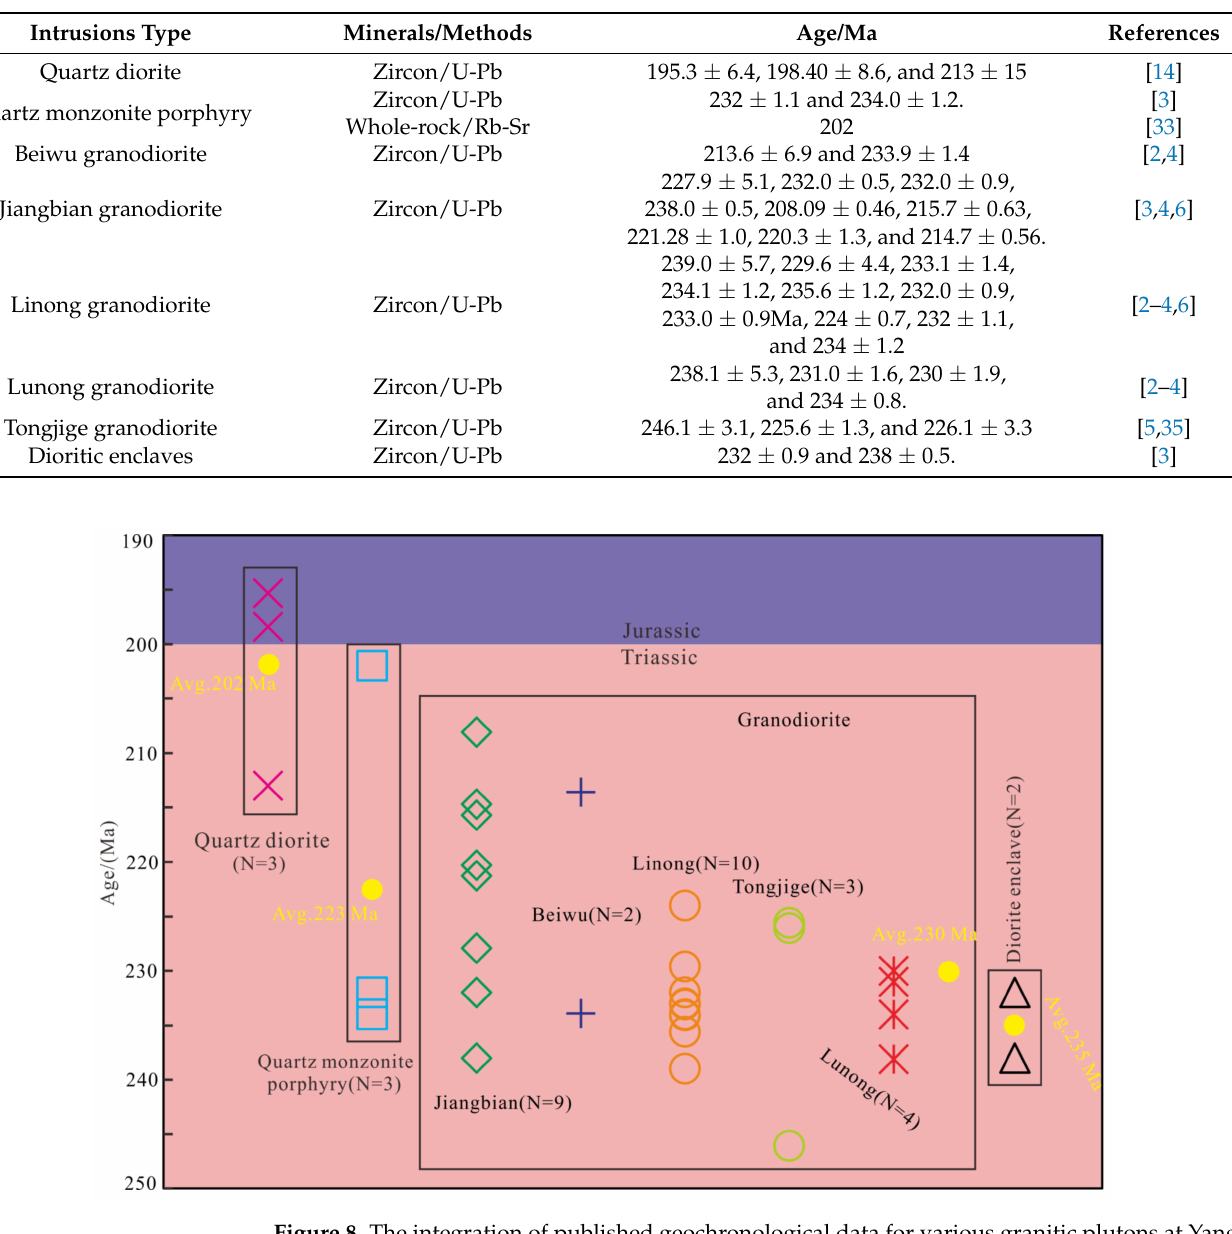
Figure 8. The integration of published geochronological data for various granitic plutons at Yangla Cu-W polymetallic deposit. The signs (i.e., circles, crosses, triangles, rhombus, and squares) represents the emplacement ages of different granitoid